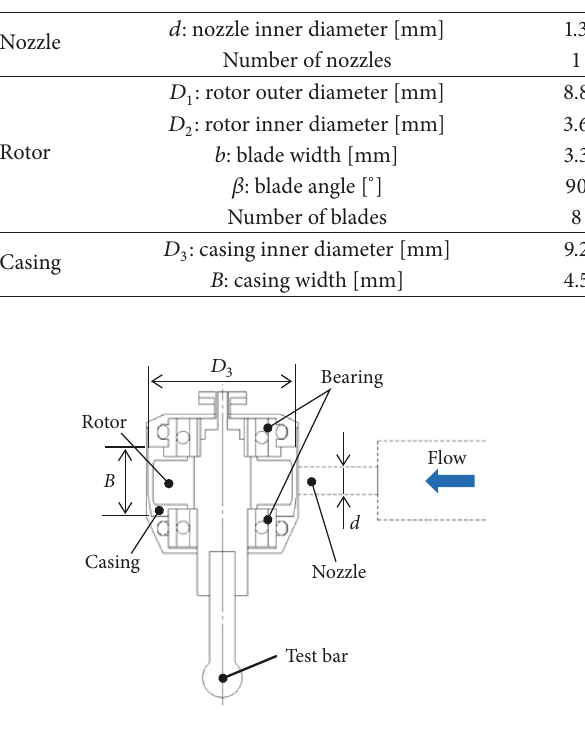
Table 1: Specifications of turbine section.